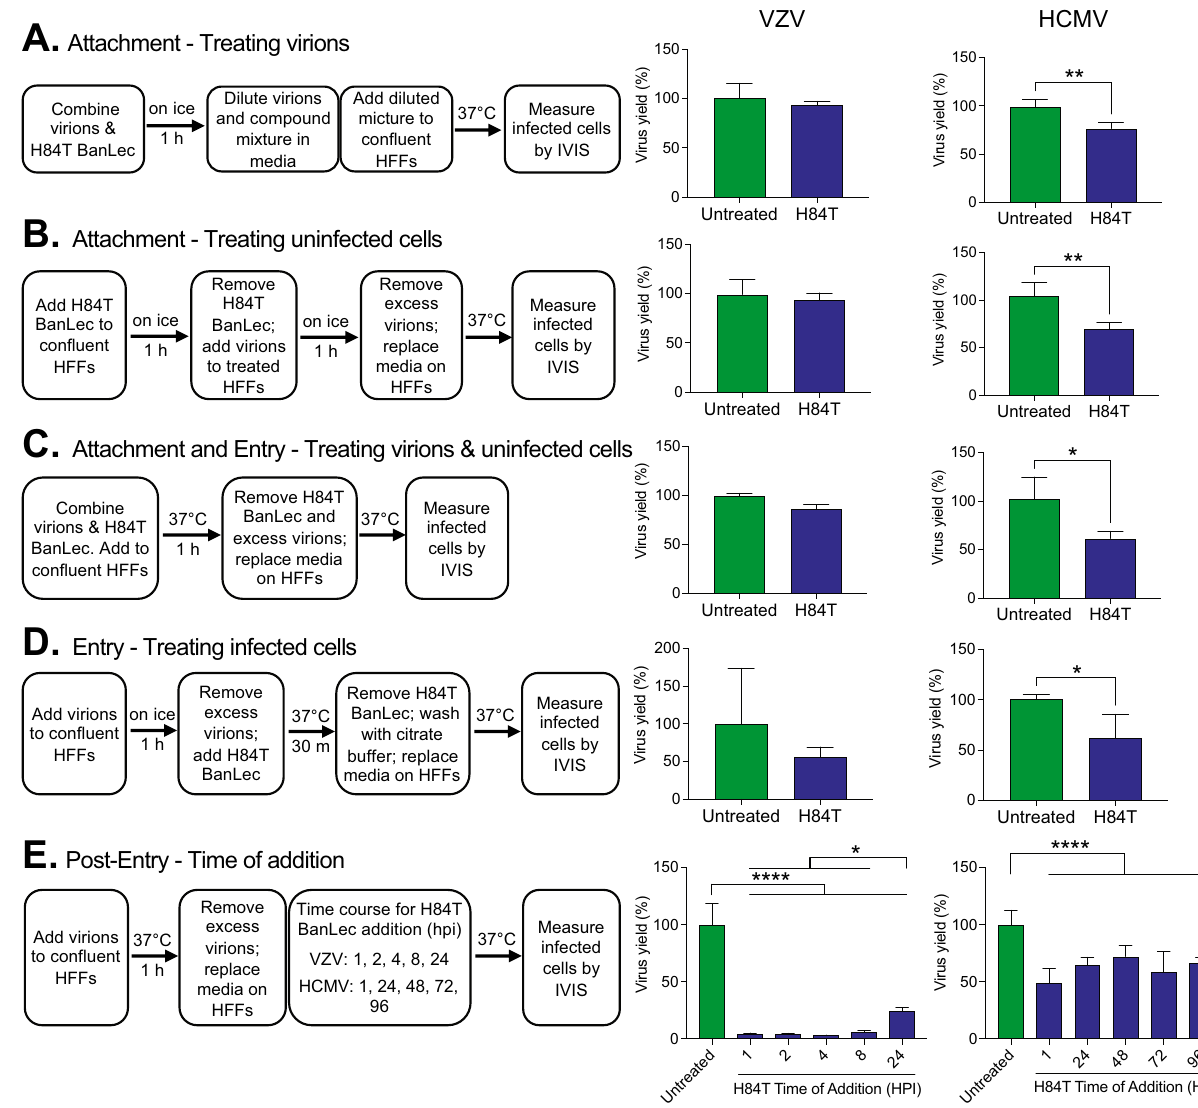
Figure 2. Effects of H84T BanLec on extracellular VZV and HCMV virions and on infected cells. Each experimental condition tests a different aspect of H84T BanLec’s mechanism of action including attachment ( A , B ), attachment and entry ( C ), entry ( D ), and post-entry steps ( E ). Cell-free virions and H84T BanLec were added to HFF cell monolayers based on the experimental design for each condition. Cell-free VZV was prepared from a fresh culture of infected HFF cells; the MOI was approximately 0.01. HCMV was prepared from a frozen, titered stock; the MOI was 0.05. H84T BanLec was used at a concentration of 100 nM for VZV and 2 µM for HCMV. ( A ) Virions were mixed with H84T BanLec on ice for 1 h, and were then diluted 1:50 for VZV and 1:1000 for HCMV prior to adding to HFFs. ( A – D ) Infected cells were measured by bioluminescence imaging 24 h post-infection for VZV, and 7 days post-infection for HCMV. ( E ) Infected cells were measured by bioluminescence imaging 48 h post-infection for VZV, and 7 days post-infection for HCMV. Virus yield (%) was calculated from the average Total Flux of untreated wells divided by the Total Flux of each well. Bars and error bars represent the mean + SD. N = 4 biological replicates. Asterisks indicate significance [* p < 0.05, ** p <